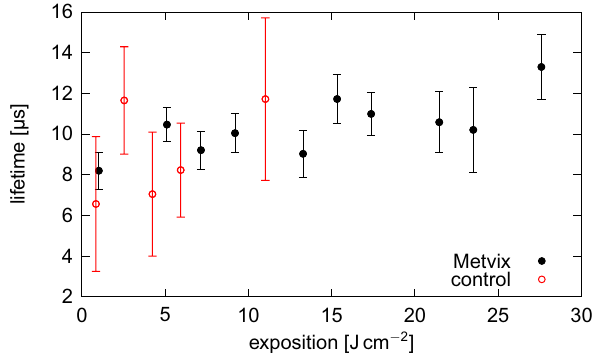
Fig. 11. Singlet oxygen phosphorescence decay times increase during the treatment both in Metvix treated (solid) and control (open)